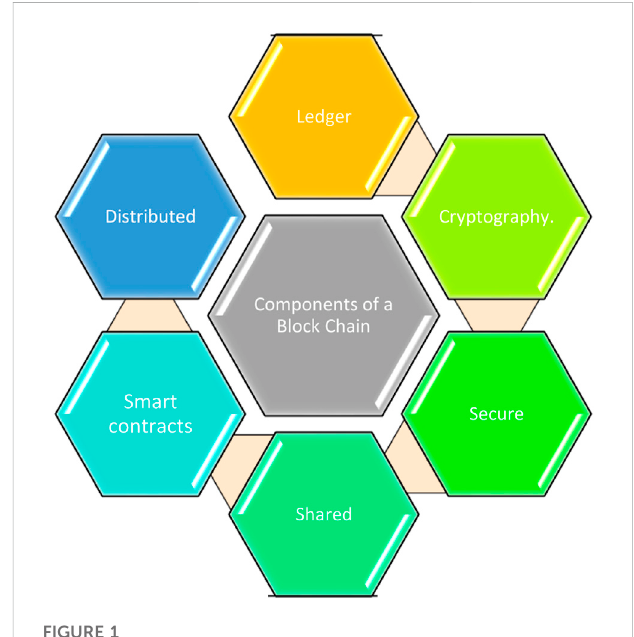
FIGURE 1 The fundamental components of a